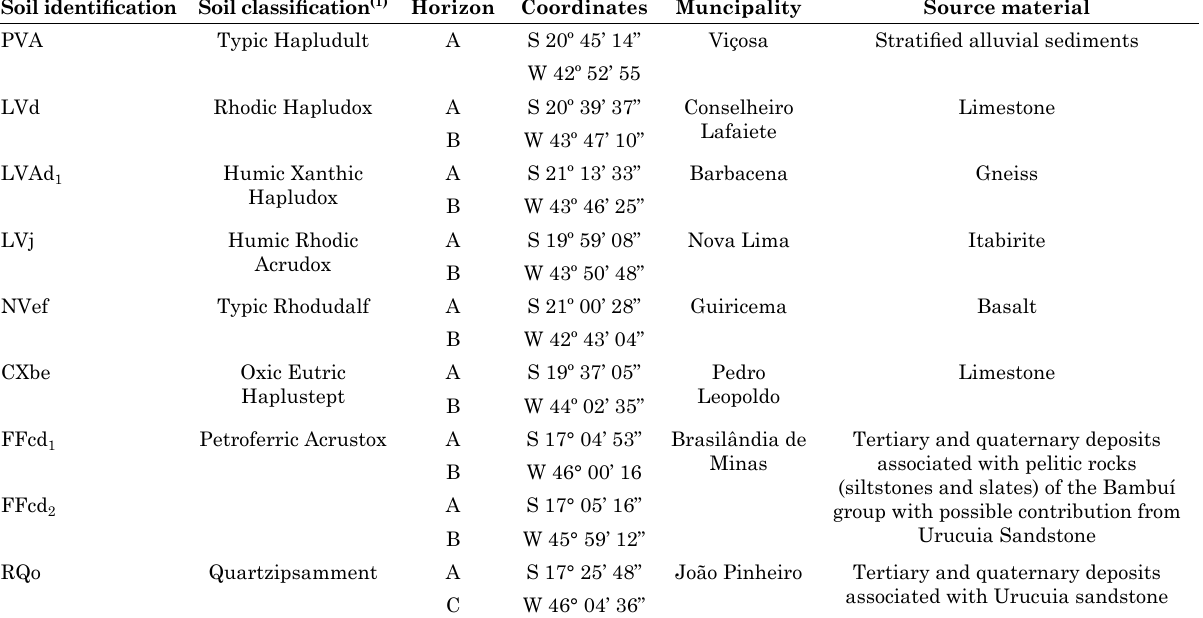
Table 1. Identification, classification, geographical location, and source material of soils used for the development and validation of the thermal desorption associated with atomic absorption spectrometry method Soil identification Soil classification (1)